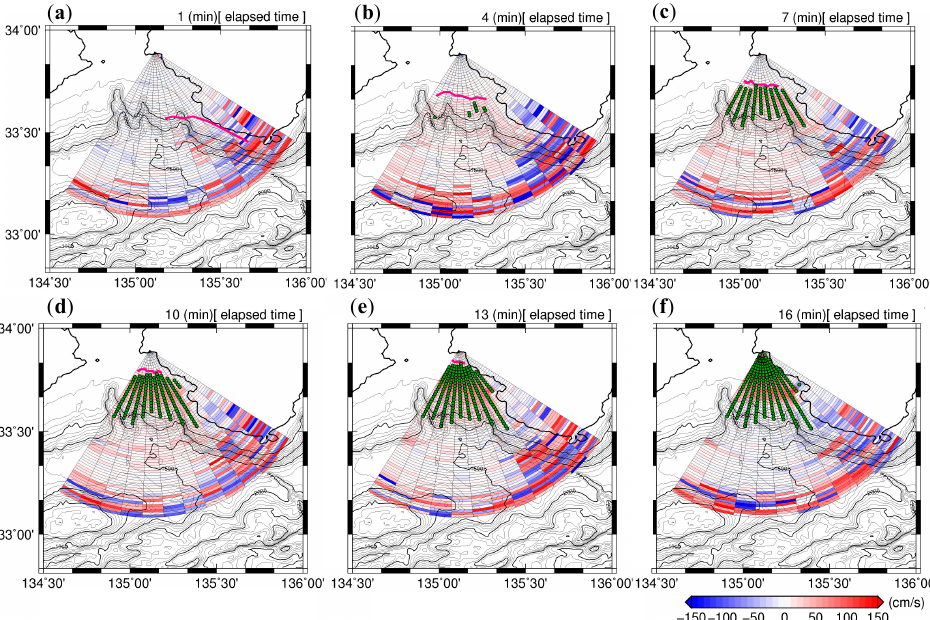
Figure 8. Spatiotemporal evolution of tsunami detection for the 02010600 scenario at ( a ) 1, ( b ) 4, ( c ) 7, ( d ) 10, ( e ) 13, and ( f ) 16 min after tsunami occurrence, and the depth contours of the Kii Channel. The background color represents v (cid:48) vt ( b , m , t ) , the green circles represent the tsunami-detected range cells, m d ( b , t ) , where TD ( b , m ) = 1, and the pink line represents the first leading wavefront of the tsunami.